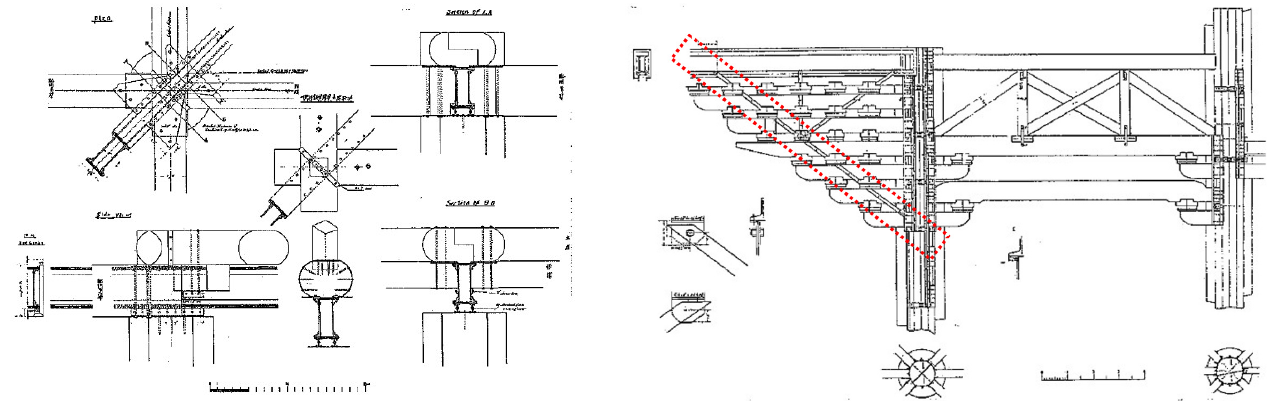
Figure 22. Daibutsuden Hall of Todaiji Temple: Iron Pins and Plates Added to Reinforce Framing during the Meiji Restoration Project [25], the metal part annotated by authors.